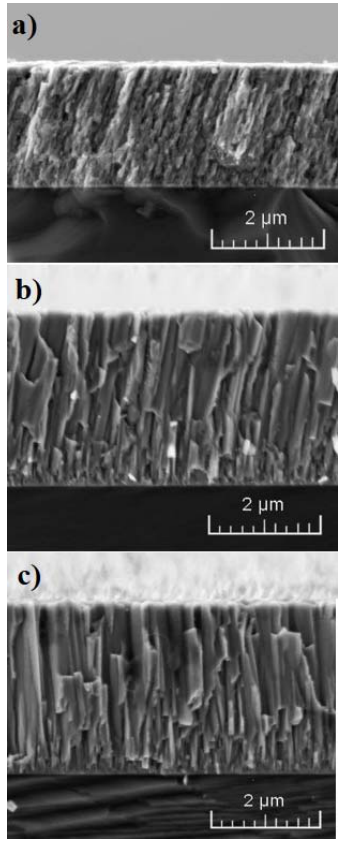
Figure 1. Cross-section SEM images of Cr x N deposited at various pressures ( a ) 300 mPa; ( b ) 600 mPa; and ( c ) 900 mPa.